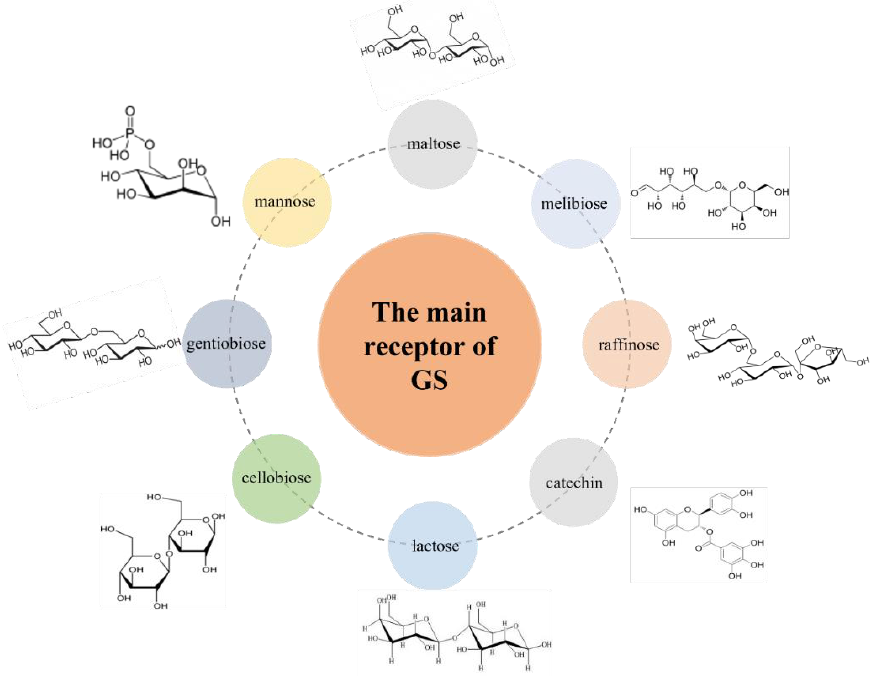
Figure 4. The main receptor of dextransucrase.